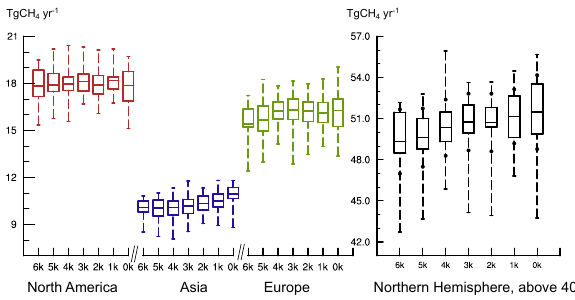
Fig. 10. Left panel: box-and-whisker plots for CH 4 emissions (TgCH 4 yr − 1 ) averaged over the domains of North America (left, red), Asia (left, blue), and Europe (left, green), for the years 6000BP until pre-industrial. The tailored box plots show the mean, minimum value, maximum value, and the 25th and 75th percentiles of a 30-yr time series. Right panel: box and-whisker plots for total CH 4 emissions (TgCH 4 yr − 1 ) of boreal wetlands above 40 ◦ N, also from 6000yrBP until